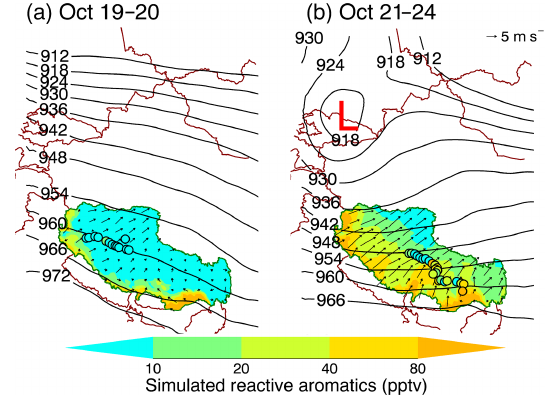
Figure 5. Distributions of WRF-simulated surface wind and REAM-simulated concentrations of reactive aromatics over the Ti- betan Plateau during 19–20 October 2010 (a) and 21–24 Octo- ber 2010 (b) . Circles show the observed reactive aromatic con- centrations. Composite distributions of simulated reactive aromatic concentrations and surface wind over Tibet, corresponding to sam- pling time of the observations, are shown in color and by arrows, respectively. Corresponding WRF-simulated 300hPa geopotential height fields are shown by contour lines. The border of the Tibet Autonomous Region is colored